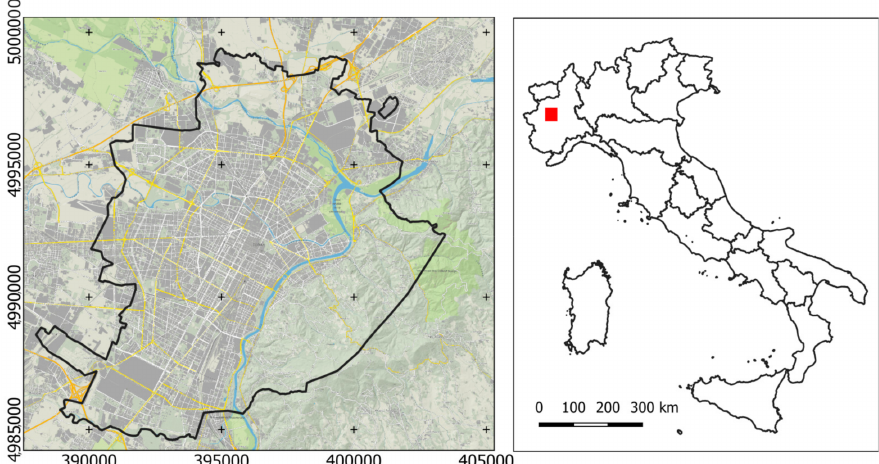
Figure 1. Torino municipality localization. On the left, the BDTRE layer uploaded from the WMS of the Piemonte Geoportal. On the right, the study area location (in red color), and the Regional administrative boundaries as provided by the National Geoportal WFS download service (http://www.pcn.minambiente.it/mattm/servizio-di-scaricamento-wfs/ (accessed on 12 May 2022)). Reference system is WGS84 UTM